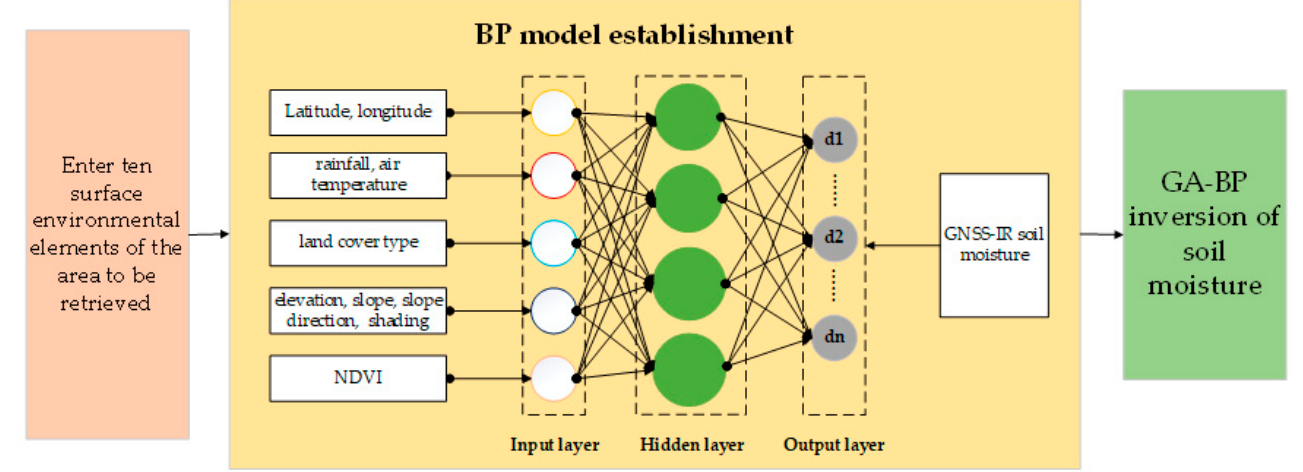
Figure 3. Structure of GA-BP neural network.